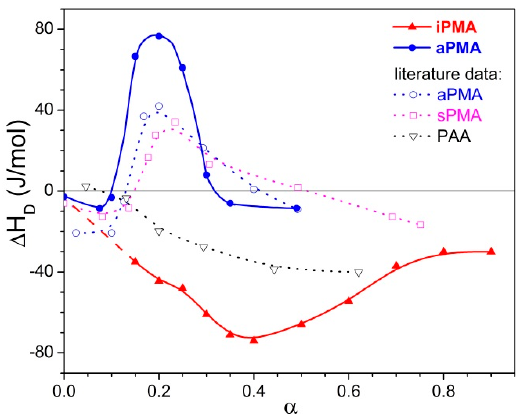
Figure 6. Enthalpies of dilution of iPMA and aPMA solutions in water (no added salt) at 25 °C as a